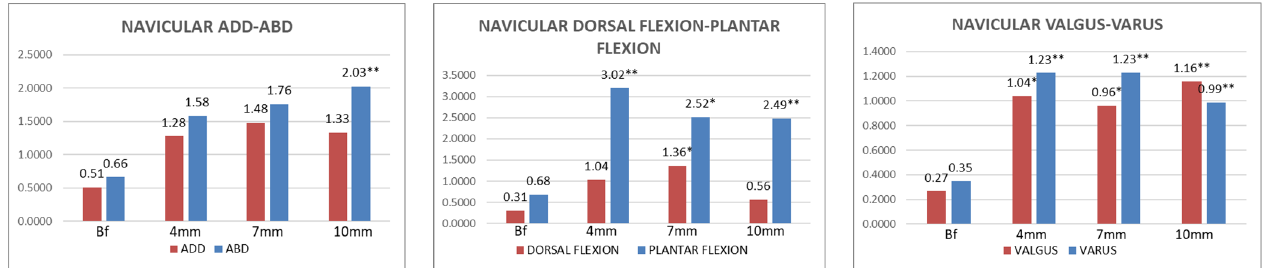
Figure 4. Graphical summary of the degrees of movement in adduction, abduction, dorsal flexion, plantar flexion, valgus, and varus for the navicular bone in four different conditions. Abbreviations: Bf = barefoot; 4 mm = lateral insoles, 4 mm; 7 mm = lateral insoles, 7 mm; 10 mm = lateral insoles, 10 mm. p -Value = level of significance; p < 0.05 * (with a 95% confidence interval) was considered statistically significant, and p < 0.001 ** (with a 95% confidence interval) was considered strongly statistically significant.